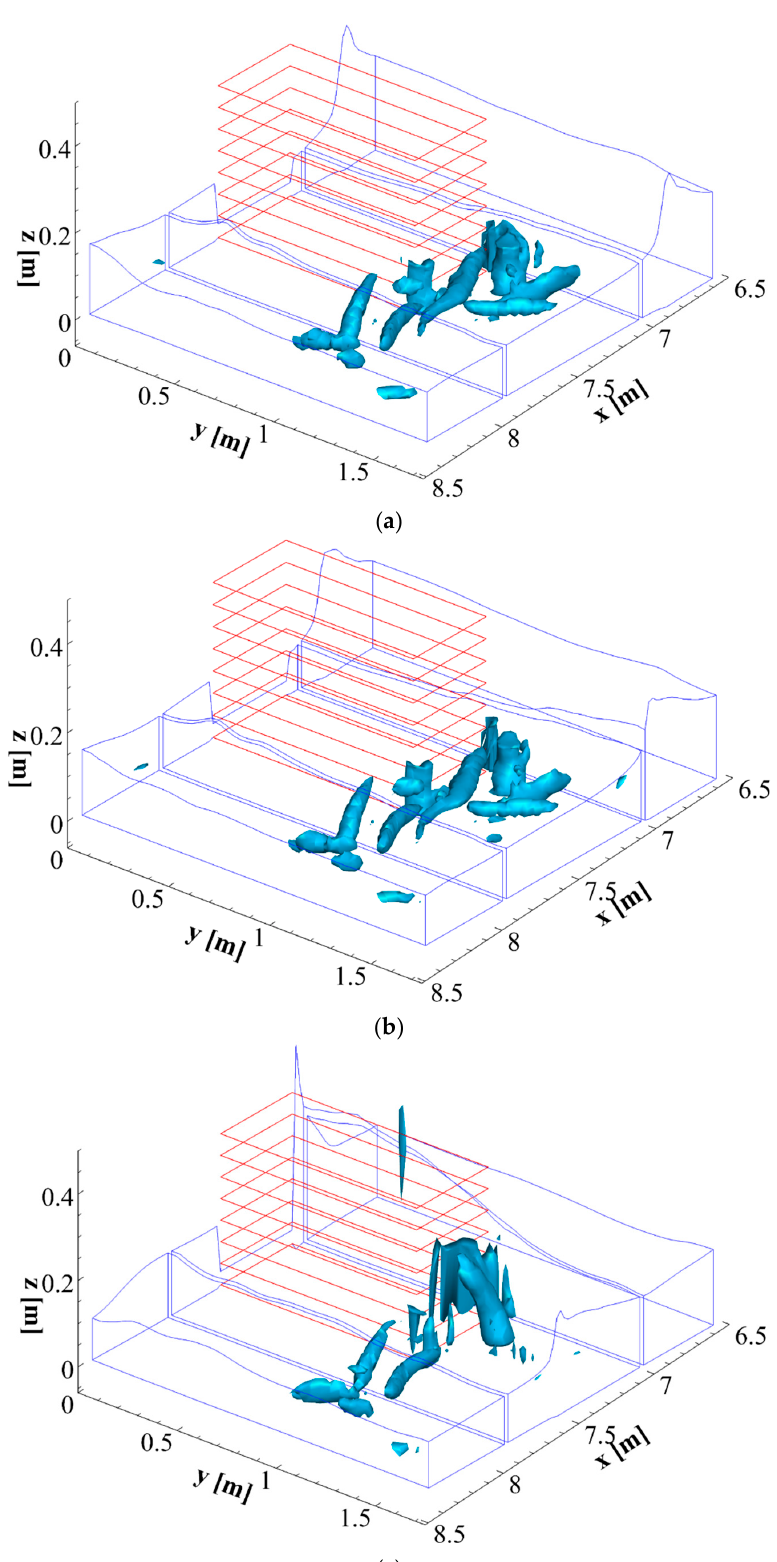
Figure 17. Wave–structure interaction. Instantaneous local vortex structures visualized using the Q-criterion (three-dimensional contours of the second invariant of the velocity gradient tensor). Three different instantaneous wave field: ( a ) T = 100 s, ( b ) T = 101 s and ( c ) T = 102